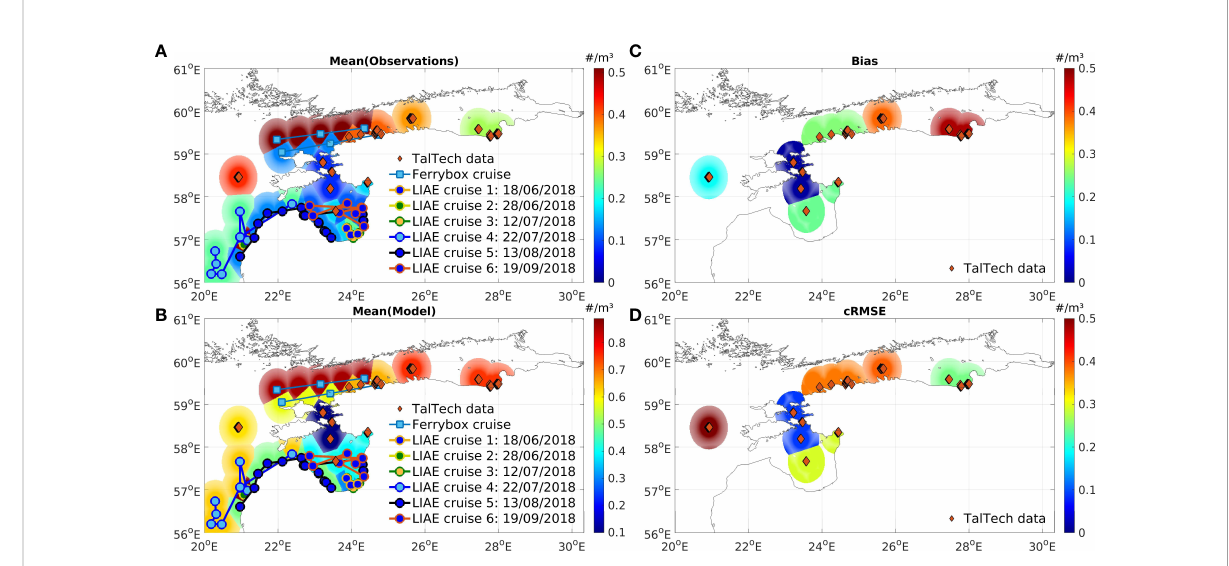
FIGURE 9 Left: Mean microplastic particle concentrations: Observed pattern (A) and modeled pattern (B) . Right: Model error statistics for TalTech data sets: Bias (C) and centered RMSE (D) . LIAE cruise data have been added in (A) and (B) but have not been used in the error analysis because of low statistical signi fi